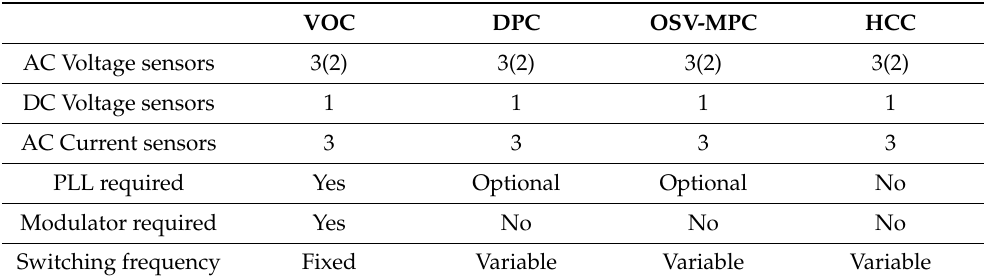
Table 3. Comparison of AFE control techniques. VOC DPC